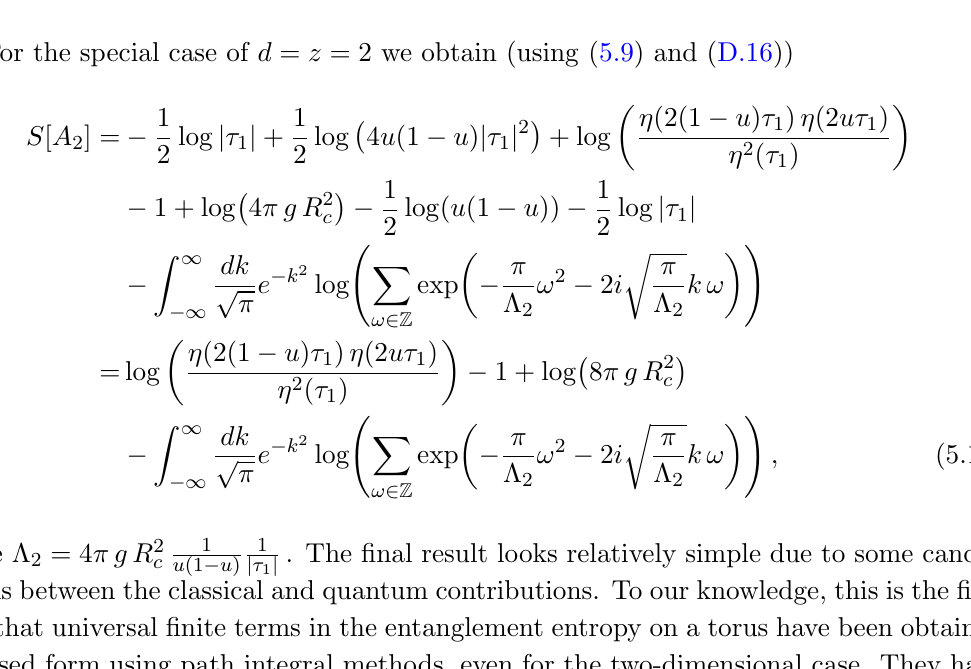
Figure 5 . We plot the (cid:12)nal expression for the universal (cid:12)nite term in the entanglement entropy on a half torus (5.17) against the number of spatial dimension d (which is equal to the critical exponent z ). We normalise S [ T d = 2] with respect to the two-dimensional case, and set g = R c = L 1 = (cid:1) (cid:1) (cid:1) = L d = 2 L A = 1 in the